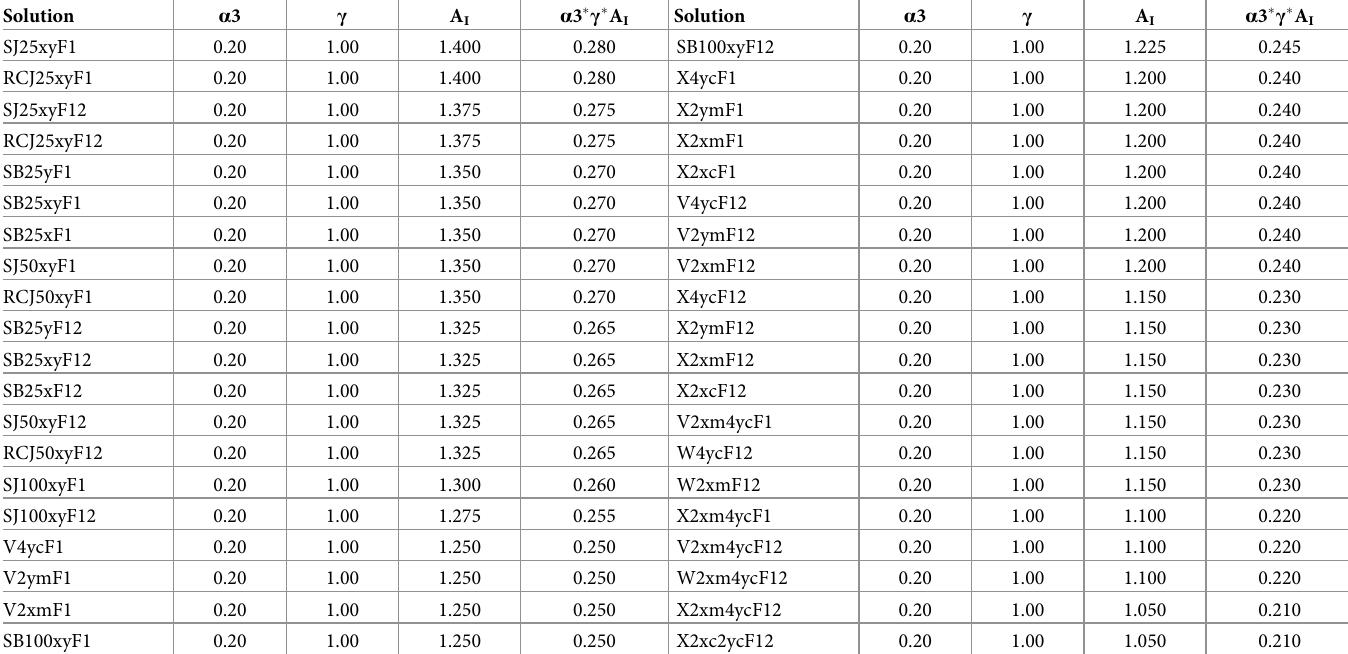
Table 4. The architectural impact of each model.